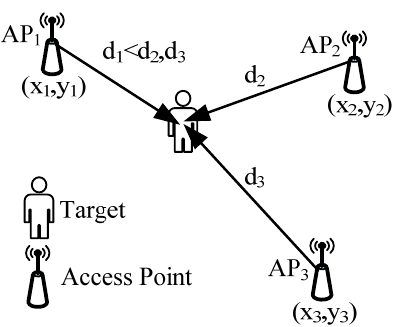
Figure 9. Proximity-based positioning Figure 9. Proximity ‐ based positioning method.